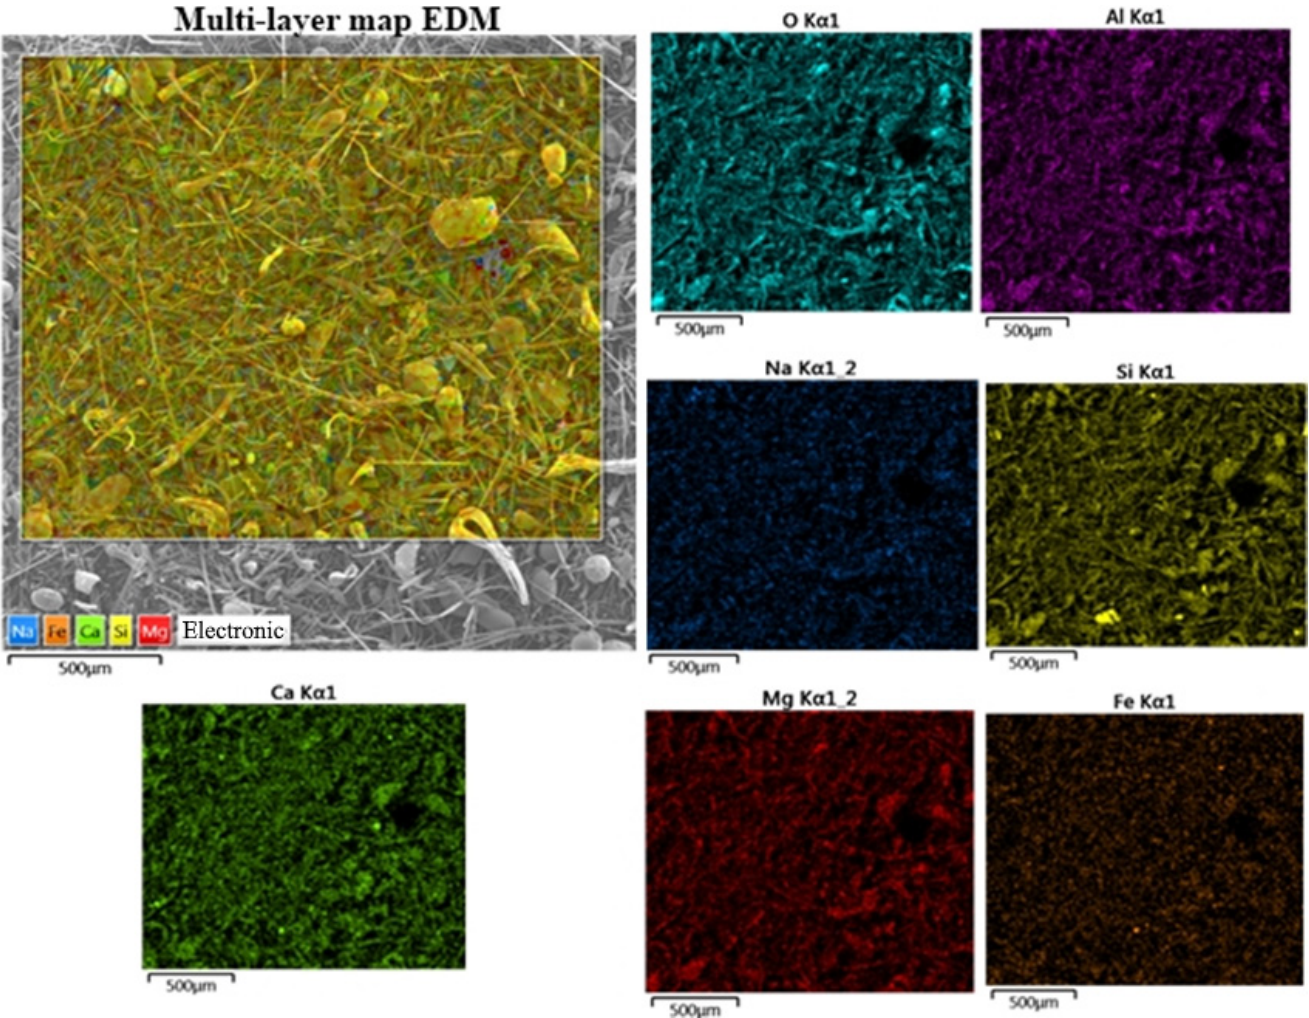
Figure 4. Distribution of chemical elements included in mineral wool waste over the surface.